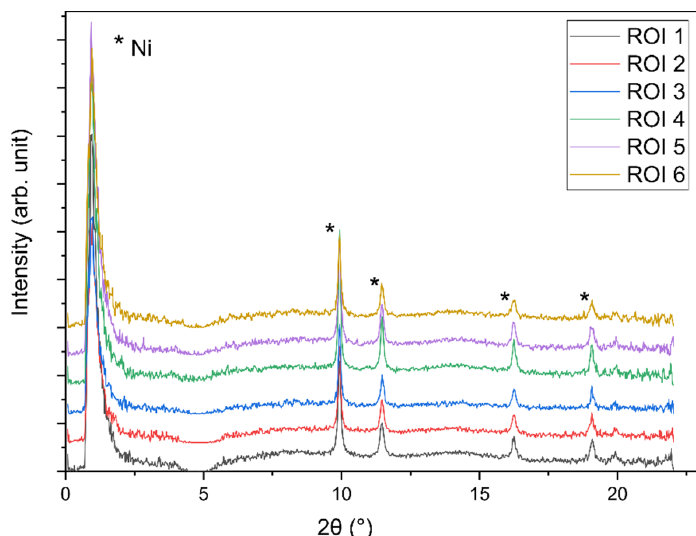
Figure 5. XRD patterns of selected regions of interest from tomography data of the activated cata-